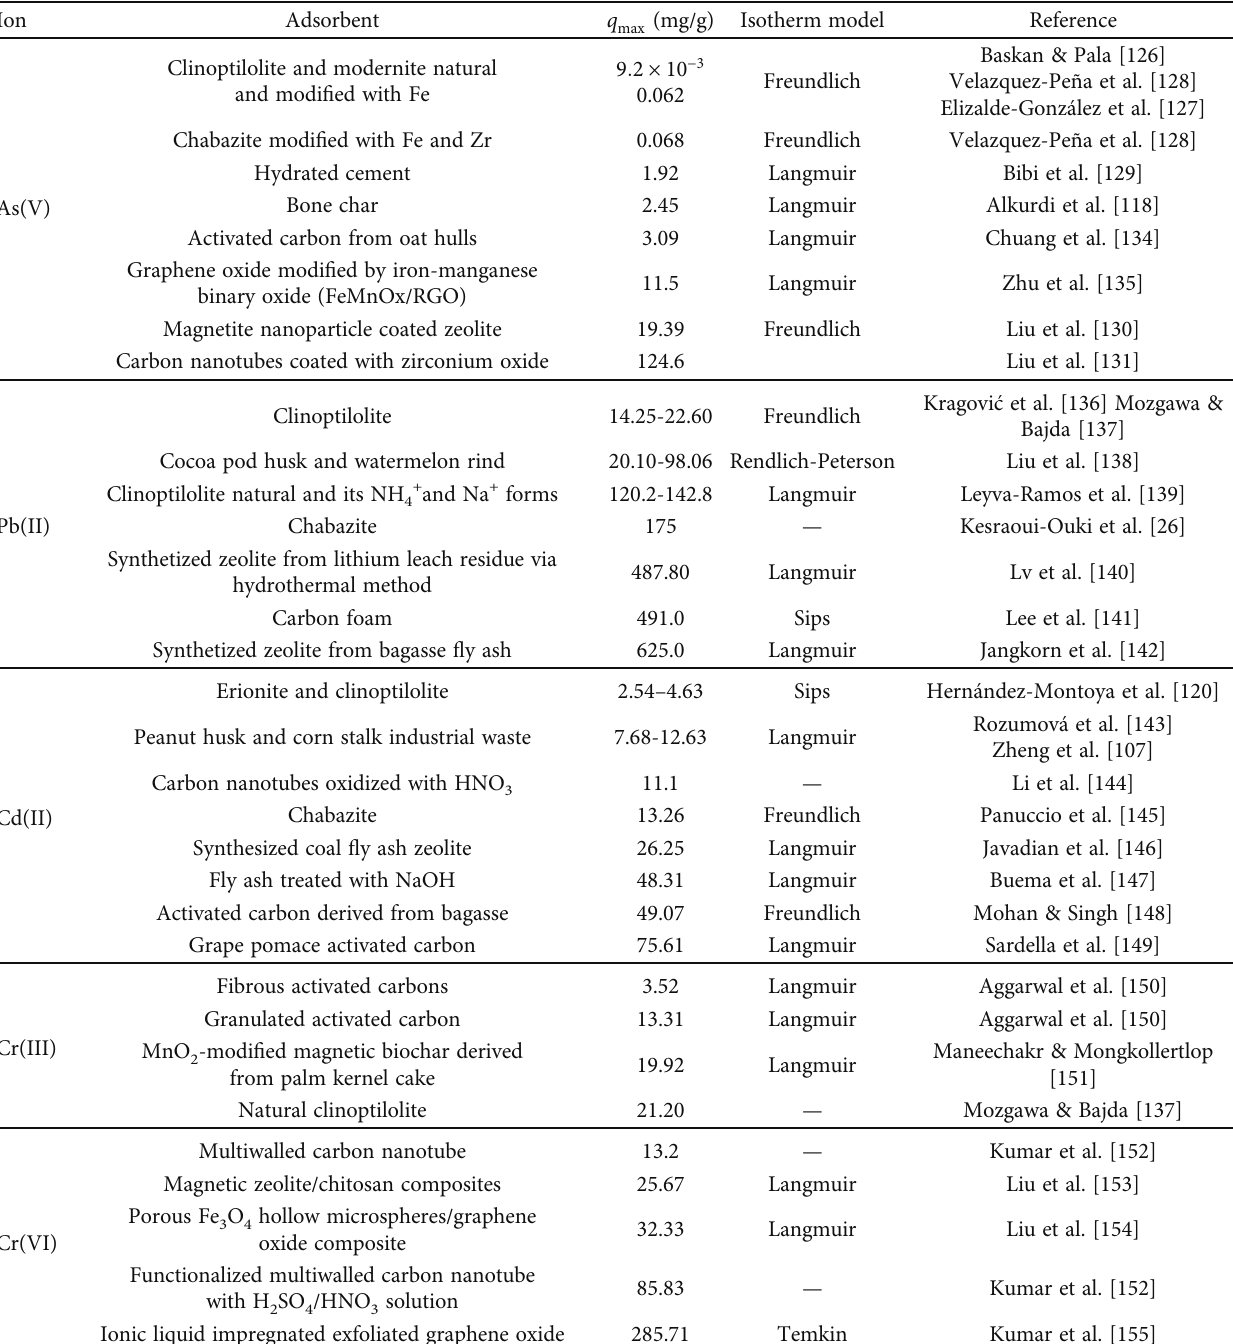
Table 4: Maximum adsorption capacities for the removal of As(V), Pb(II), Cd(II), and Cr(III) using di ff erent materials.